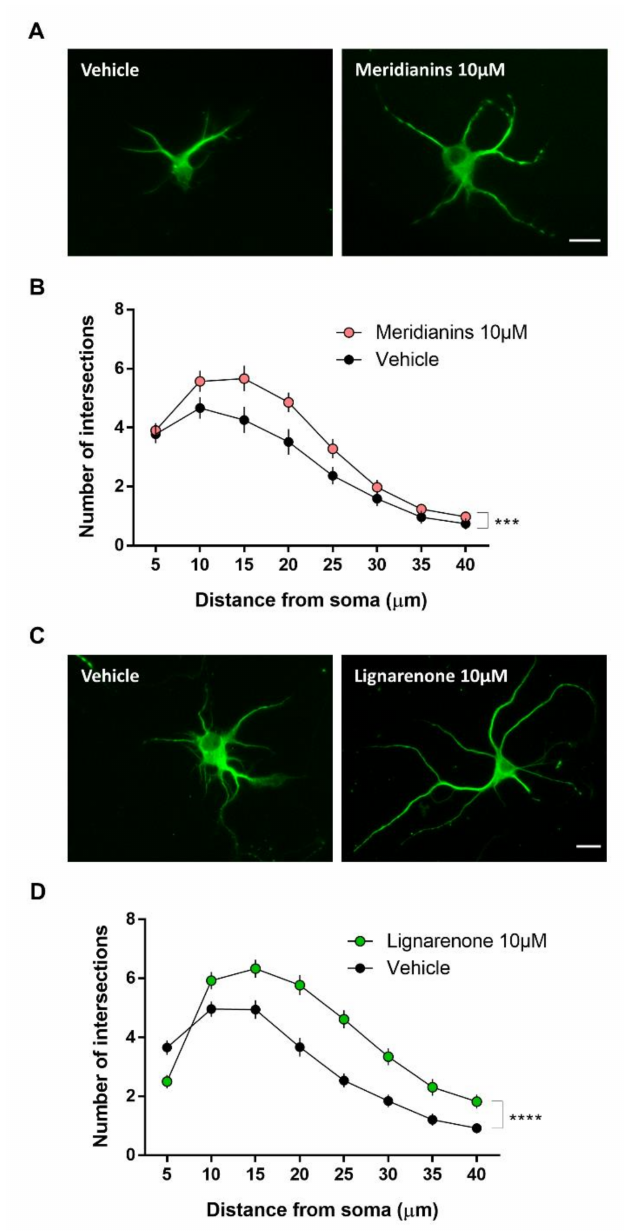
Figure 7. Meridianins and lignarenone B up-regulate neurite complexity in vitro. ( A ) Representative MAP2 images obtained by epifluorescent microscopy from primary cortical neurons treated with vehicle or meridianins 10 µ M. Scale bar, 40 µ m. ( B ) Sholl analysis from MAP2-positive neurons (two-way ANOVA analysis; interaction e ff ect, number of dendrites, F 7, 536 = 55.91, p < 0.001). n = 45–55 neurons per condition. ( C ) Representative MAP2 images obtained by epifluorescent microscopy from primary cortical neurons treated with vehicle or lignarenone B 10 µ M. Scale bar, 40 µ m. ( D ) Sholl analysis from MAP2-positive neurons (two-way ANOVA analysis; interaction e ff ect, F 7, 815 = 7.247, p < 0.0001; group e ff ect, F 7, 815 = 67.90, p < 0.0001; number of dendrites, F 7, 815 = 72.51, p < 0.0001). n = 45–5 neurons per condition. *** p < 0.001 and **** p < 0.0001 when compared with